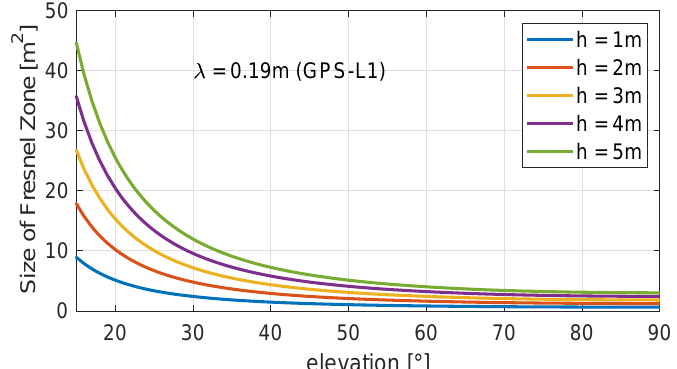
Figure 6. Size of Fresnel zone for different satellite elevation angles and antenna heights determined for the GPS-L1 carrier wavelength.